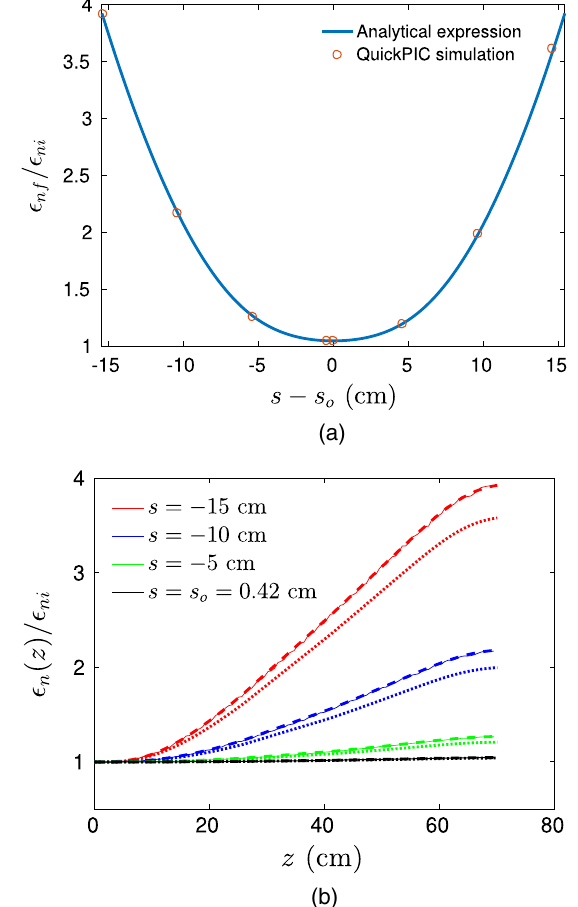
FIG. 4. Witness beam ’ s emittance growth for different focal planes, s , in the adiabatic plasma in Fig. 3(b). (a) The ratio of final emittance (at the plasma exit) to the initial emittance (at the plasma entrance) for different cases. (b) The evolution of ϵ n inside the plasma for 4 different cases, corresponding to the 4 orange spots for s − s o ≤ 0 in (a). The solid lines are from QuickPIC simulations, the dashed lines are from expression (13), and the dotted lines are from expression (15).